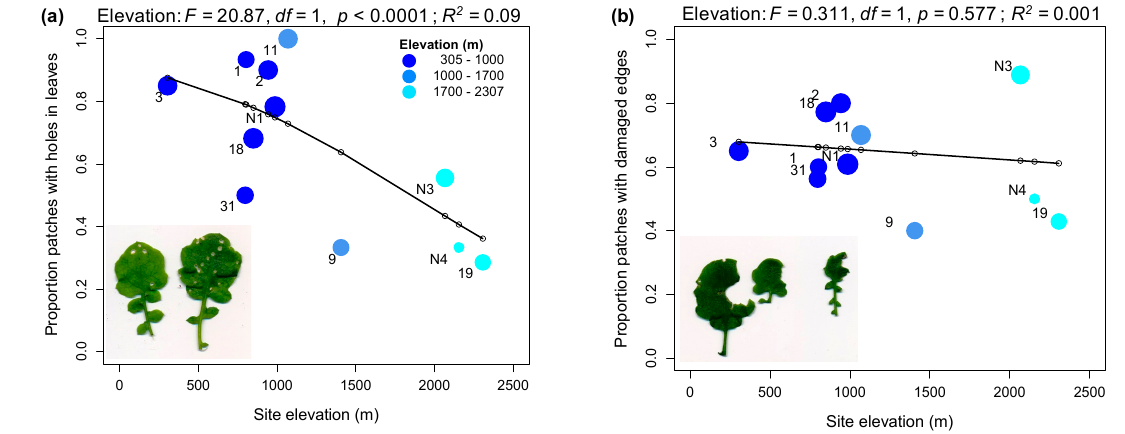
Figure 2. Variation in the proportion of plant patches in the field showing different damage types. ( a ) proportion of patches with holes in leaves. ( b ) proportion of patches with damaged leaf edges. Point size is scaled by sample size (number of patches) and a line joins fitted value estimates from the corresponding linear model with elevation as a factor. Points are labelled by population identifiers.